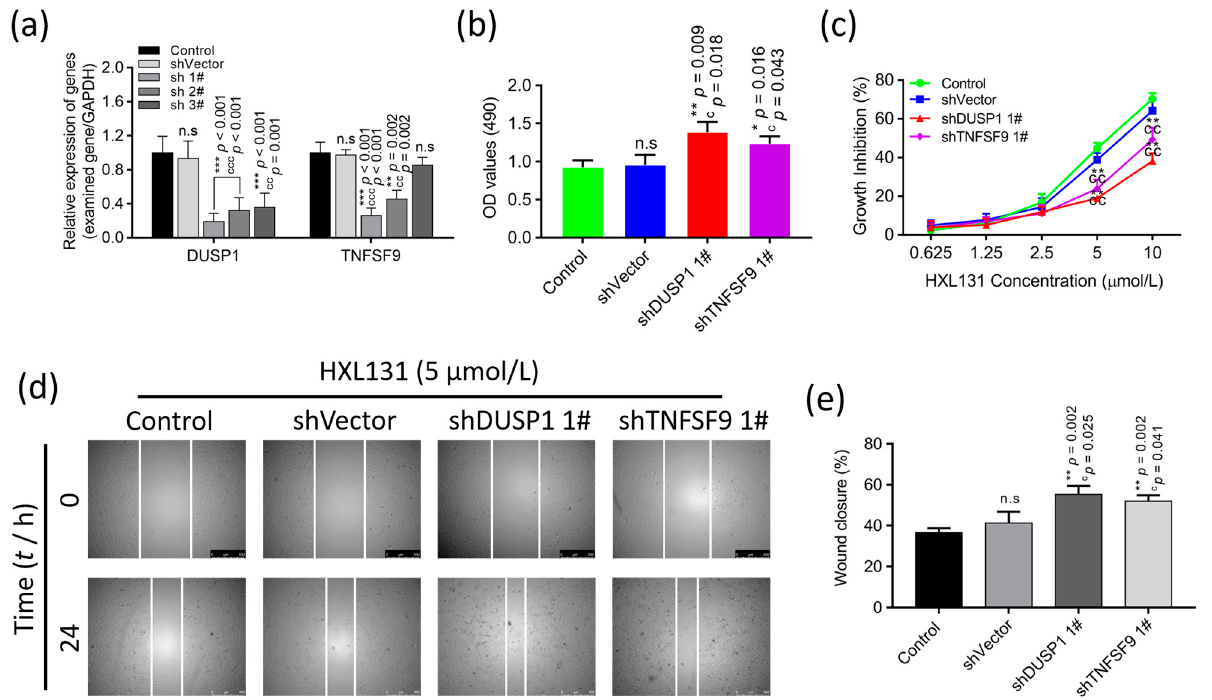
Figure 8. Gene silencing validates the effect of interfering with the expression of DUSP1 and TNFSF9 on the growth and metastasis of PC3 cells. ( a ) Real-time quantitative PCR (RT-qPCR) to verify the interference effect of three sequences; ( b ) OD values of the cells in each group were detected by the MTT method at 24 h. This value is proportional to the number of viable cells; ( c ) MTT assay was used to detect the effect of HXL131 on cell proliferation in each group; ( d ) Wound-healing assay was used to detect the effect of HXL131 on cell migration in each group (the magnification = ×50, scale bar represents 500 µm); ( e ) shDUSP1 1# and shTNFSF9 1# promotes migration of PC3 cells at the scratch. “Control” indicates no transfection of any plasmid, “shVector” indicates the empty vector transfected without the target plasmid, “shDUSP1 1#” indicates that plasmid 1# containing DUSP1 was transfected, and “shTNFSF9 1#” indicates that plasmid 1# containing TNFSF9 was transfected. Values are mean ± SD ( n = 3). * p < 0.05, ** p < 0.01, *** p < 0.001 vs. Control group; c p < 0.05, cc p < 0.01, ccc p < 0.001 vs. shVector group; n.s, non-significant. Multiple t -tests and one-way ANOVA were used for statistical analysis.